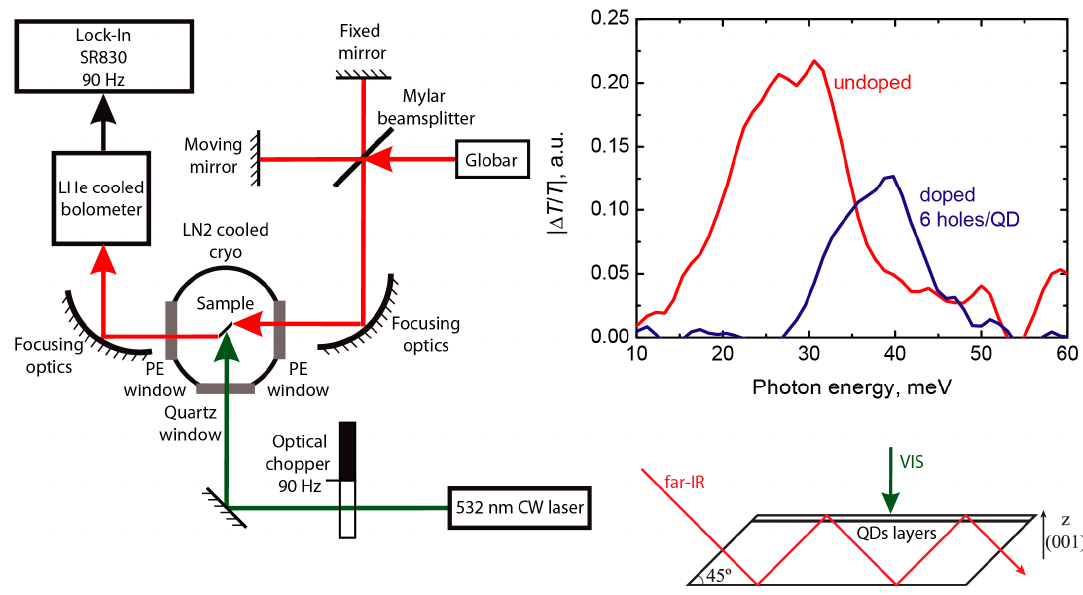
Figure 3. Experiment schematics and the measured spectra of the change of far-IR transmission due to external interband photoexcitation at 80 K. Data are plotted for undoped Ge/Si quantum dot structure (red curve) and doped structure (blue curve) with nominal doping of 6 holes/dot.